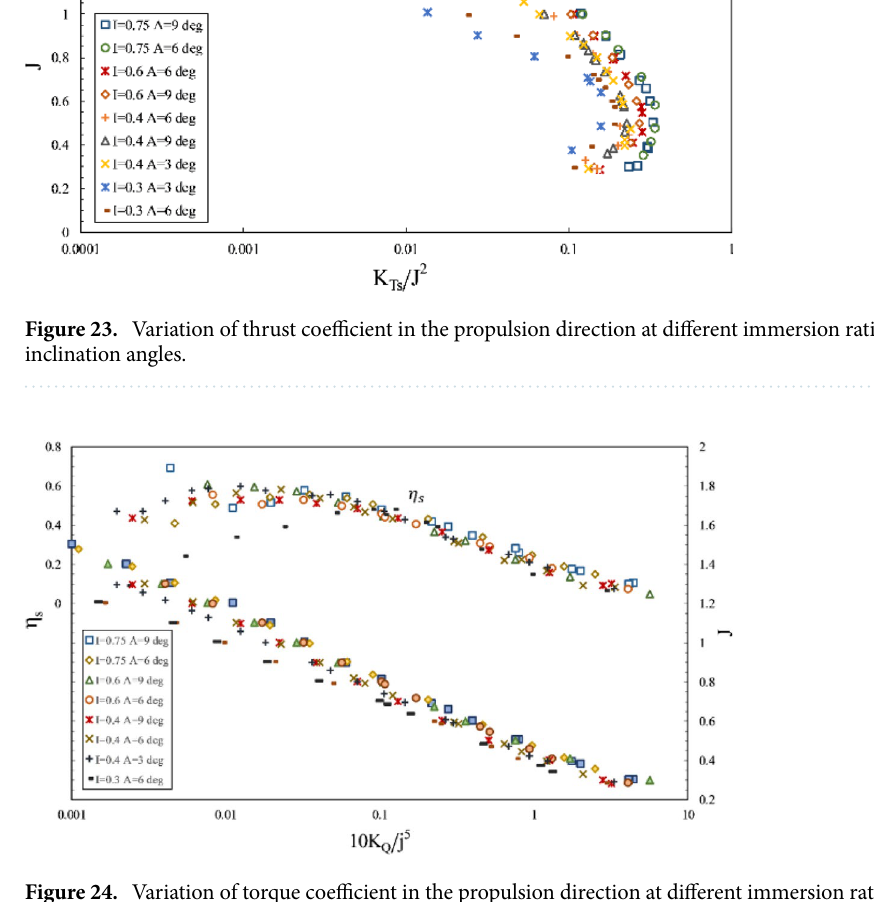
Figure 24. Variation of torque coefficient in the propulsion direction at different immersion ratios and inclination angles.